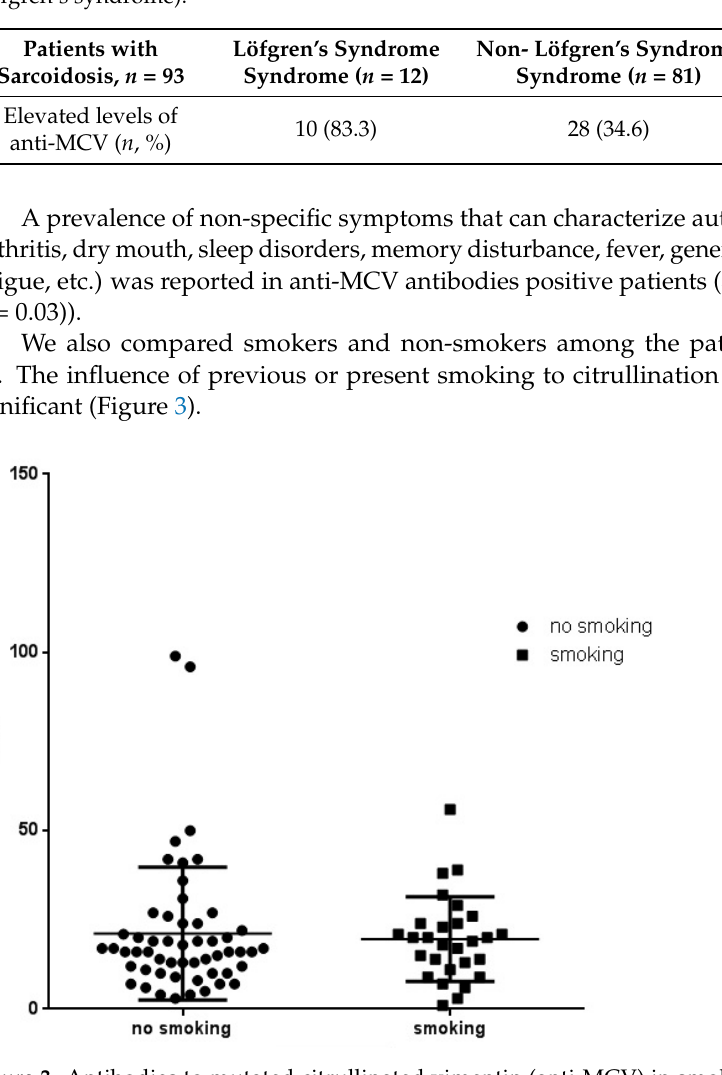
Figure 3. Antibodies to mutated citrullinated vimentin (anti-MCV) in smoking and non-smoking patients with sarcoidosis ( p = 0.6180)